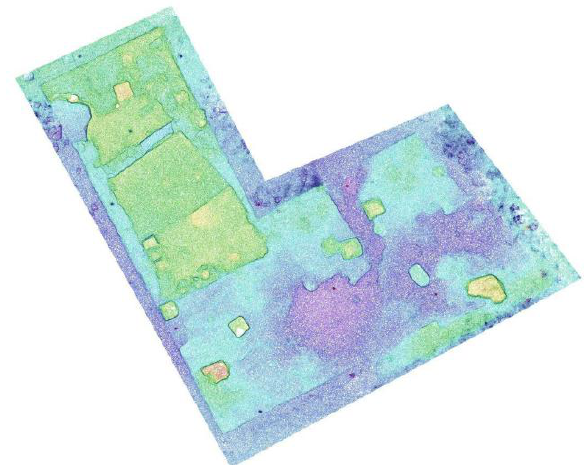
Figure 3. Overall plan of the workshop as a point cloud